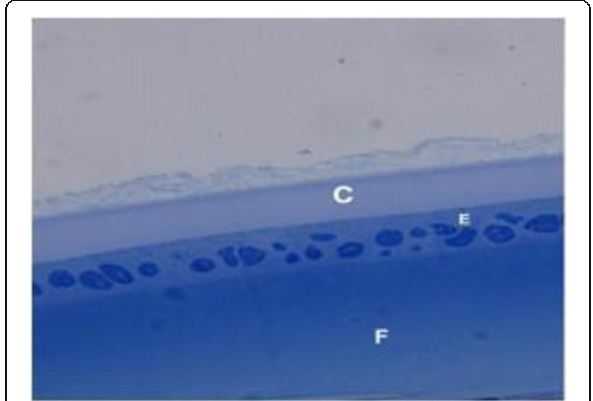
Fig. 11 Light micrograph of rat lens of diabetic model treated with 4-PBA (group 3) showing intact lens epithelium (E) and lens fiber cells (F). However, the lens capsule is still thickened (C) (Toluidine blue × 500)